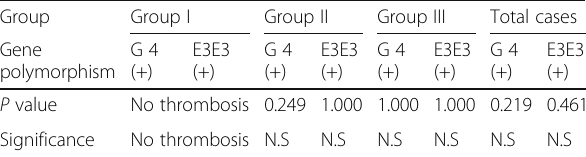
Table 12 Statistical significance for relation between thrombotic severity versus gene polymorphism (G4 and E3E3) in each group and total